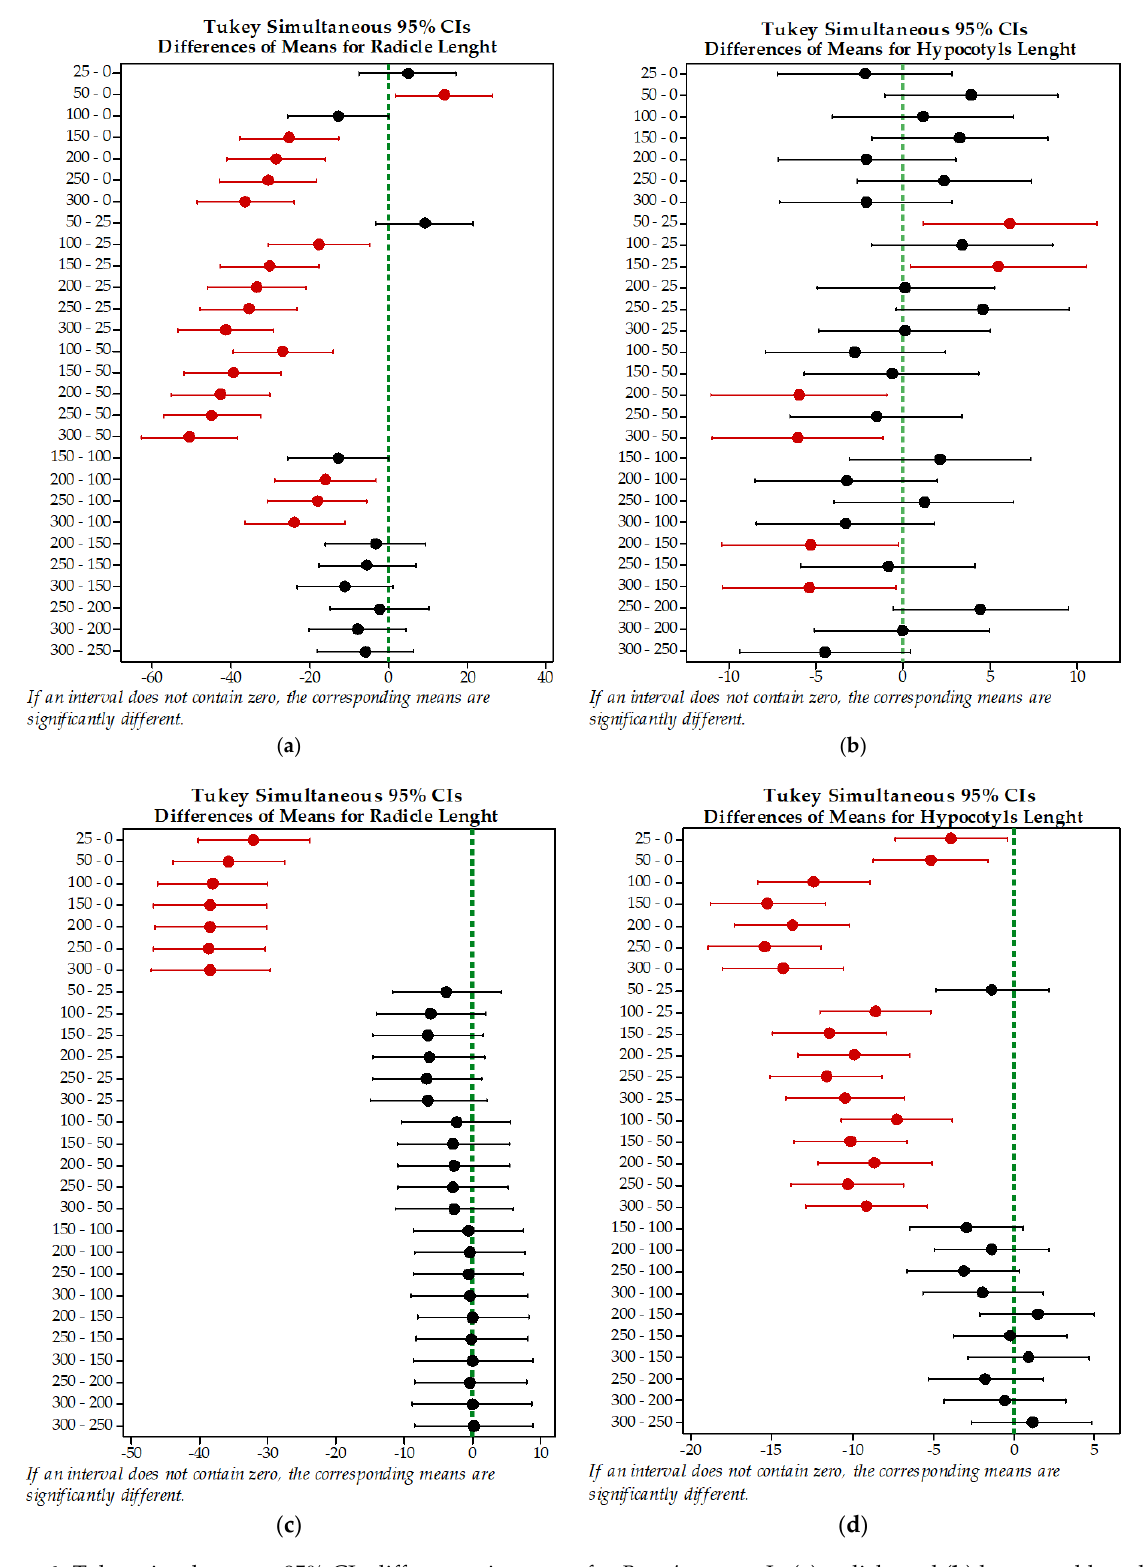
Figure 6. Tukey simultaneous 95% CIs differences in means for Brassica napus L: ( a ) radicle and ( b ) hypocotyl length at different levels of Pb(II) in solution and ( c ) radicle and ( d ) hypocotyl length at different levels of Cd(II) in solution (the intervals that do not contain zero are marked with red). The vertical green dotted line indicates the point where the difference between the means is equal to zero, • estimated value of the difference between the means